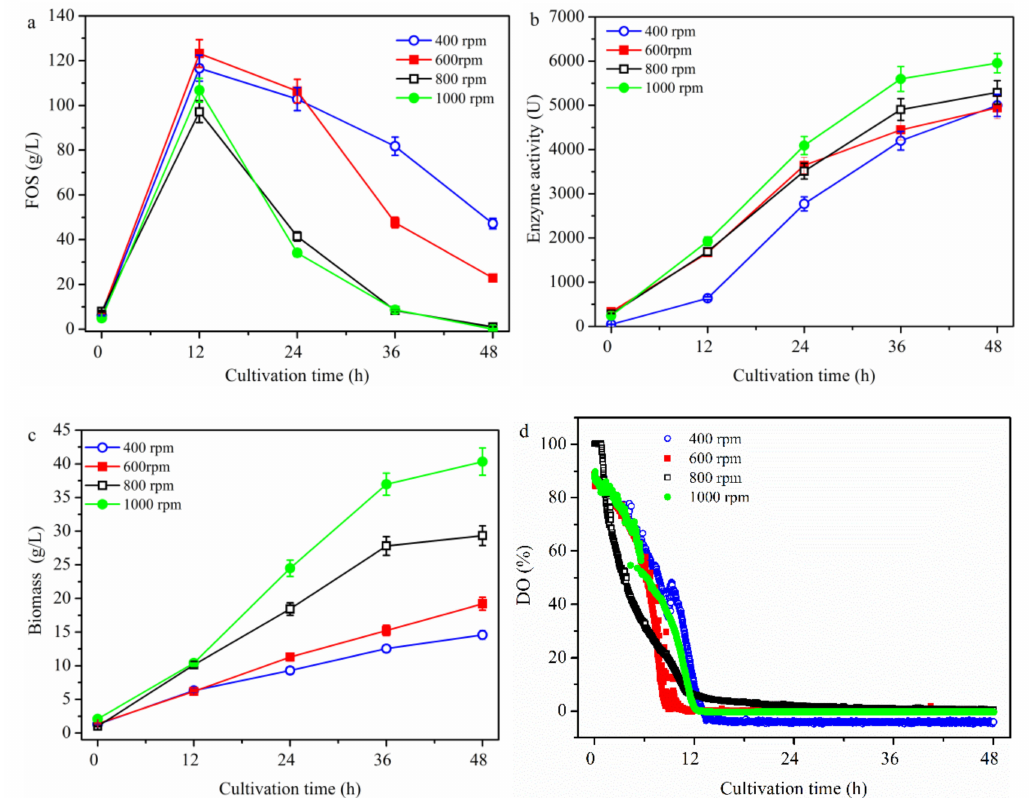
Figure 2. Time profiles of the batch cultivation at different stirring speed values. The A. pullulans ipe-3 strain was cultivated in a 2.7 L bioreactor at pH 5.5, aeration rate 1.8 L/min, and 25 ◦ C at different stirring speeds. The time courses refer to ( a ) FOS, ( b ) enzyme activity, ( c ) biomass, and ( d ) DO. The working volume was 1.8 L. Data are given as the mean ± SD, n =